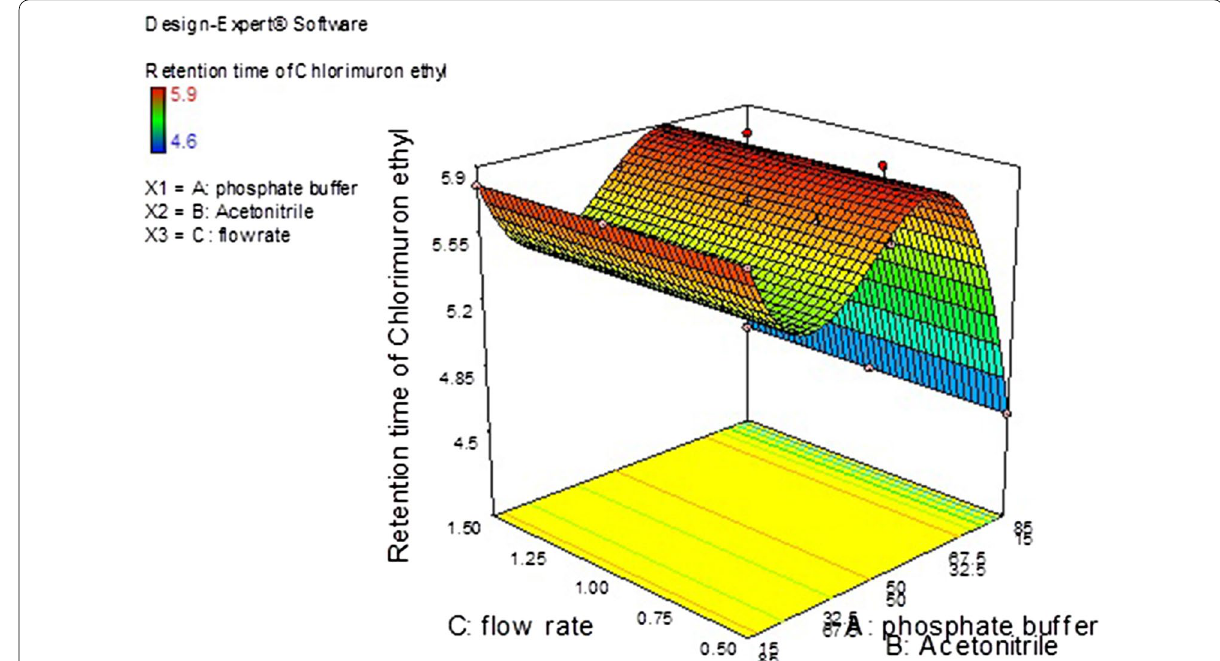
Fig. 4 3D surface plots showing retention time of chlorimuron-ethyl as response